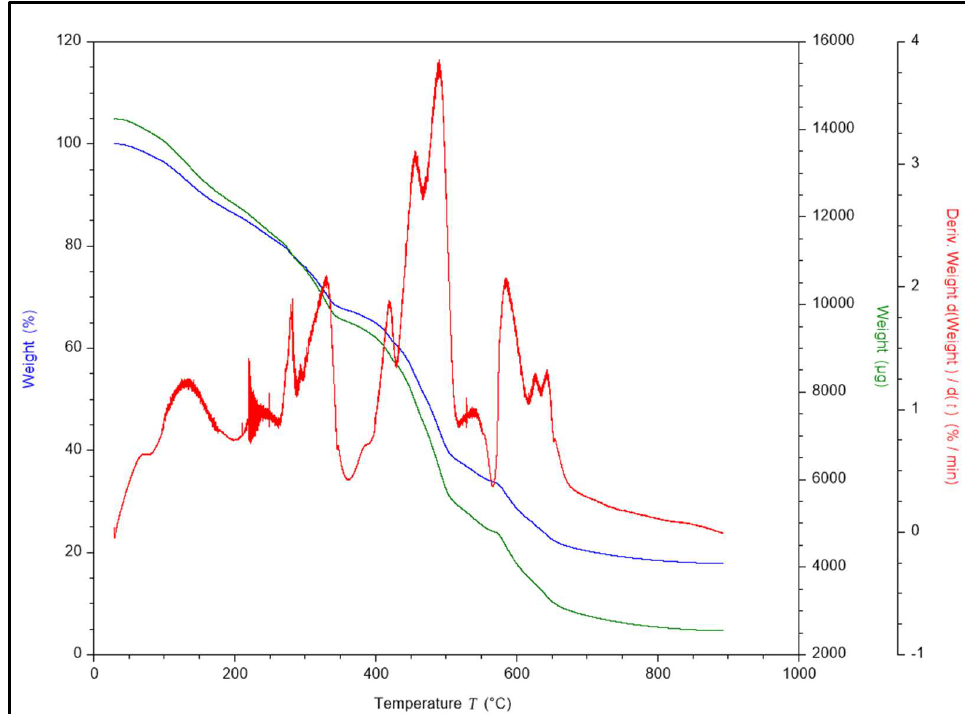
Figure 8. TGA analysis of